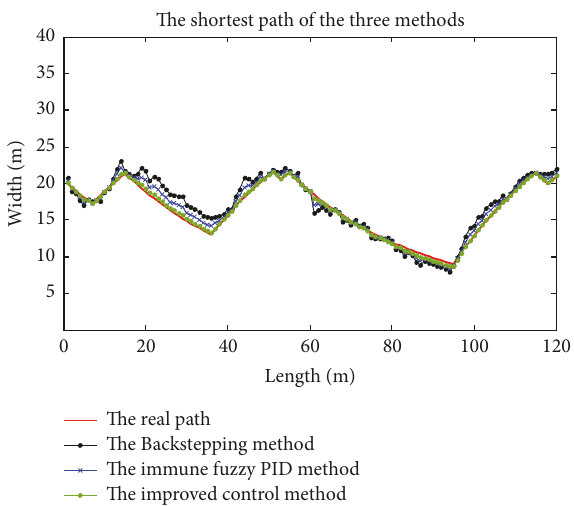
Figure 5: The comparison of the shortest paths of the three-control methods.